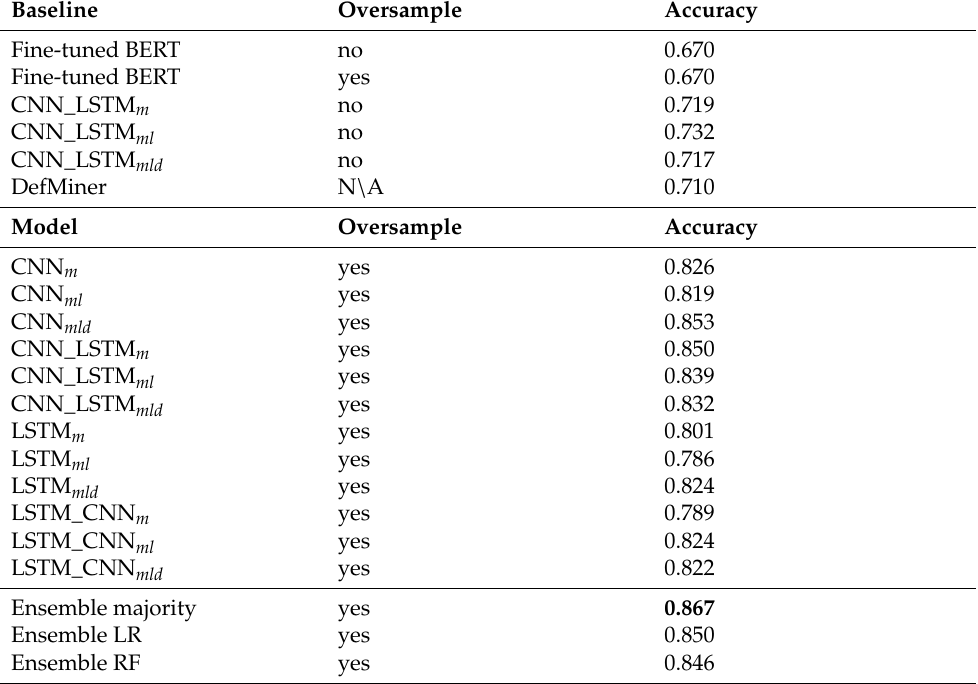
Table 4. Final results for the DEFT dataset.